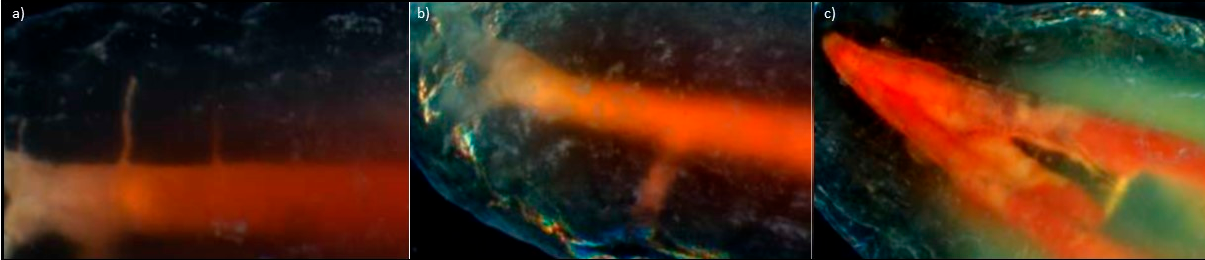
Figure 13. Lateral tubules in the research material subjected to decalcification, viewed with LSM: ( a ) in the apical part of the root canal, filled in the direction from the root apex, successively—the first with a sealant, the second with a gutta-percha substitute material centrally and centrifugally with a sealant, and the third with a gutta-percha substitute material; ( b ) single, in the apical part of the root canal, filled with replacement material based on gutta-percha; ( c ) single, connecting two main canals in the middle part of the tooth root filled with a sealant.